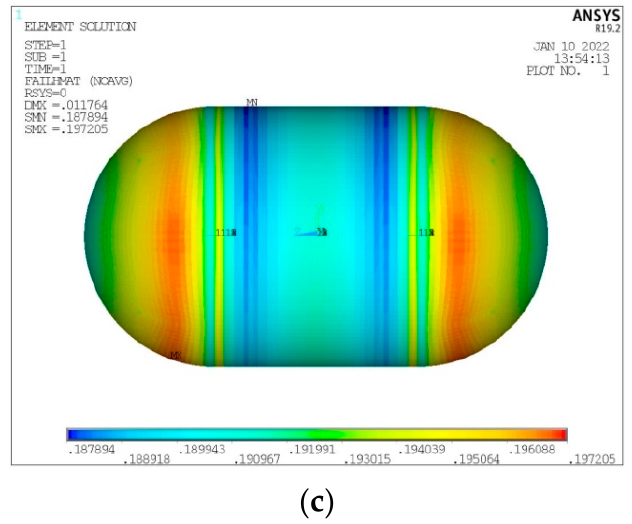
Figure 12. Distribution of ( a ) Tsai–Wu index, ( b ) Hashin fiber failure criterion and ( c ) Hashin matrix failure criterion on the outer composite shell.